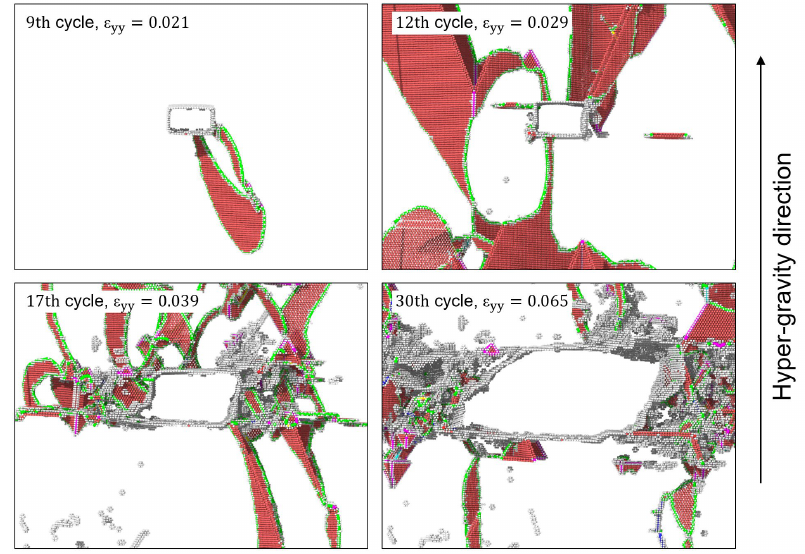
− 2](111) crack at 300 K and 1 × 10 12